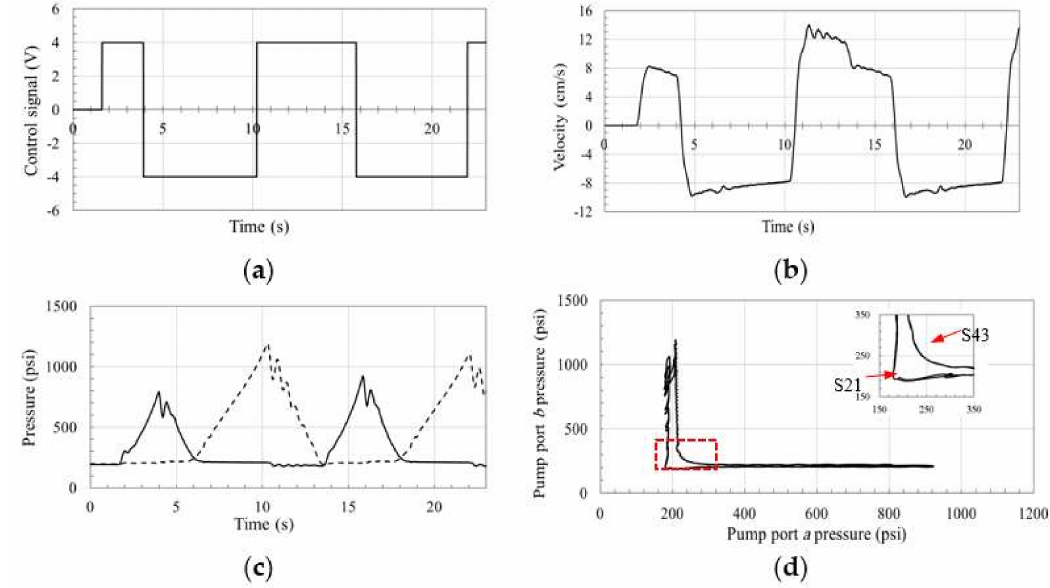
Figure 19. Performance of the circuit using SQVs for a 368 kg attached mass: ( a ) input control signal; ( b ) actuator velocity; ( c ) pressures at the pump ports a (solid line) and b (dotted line); ( d ) pump pressure